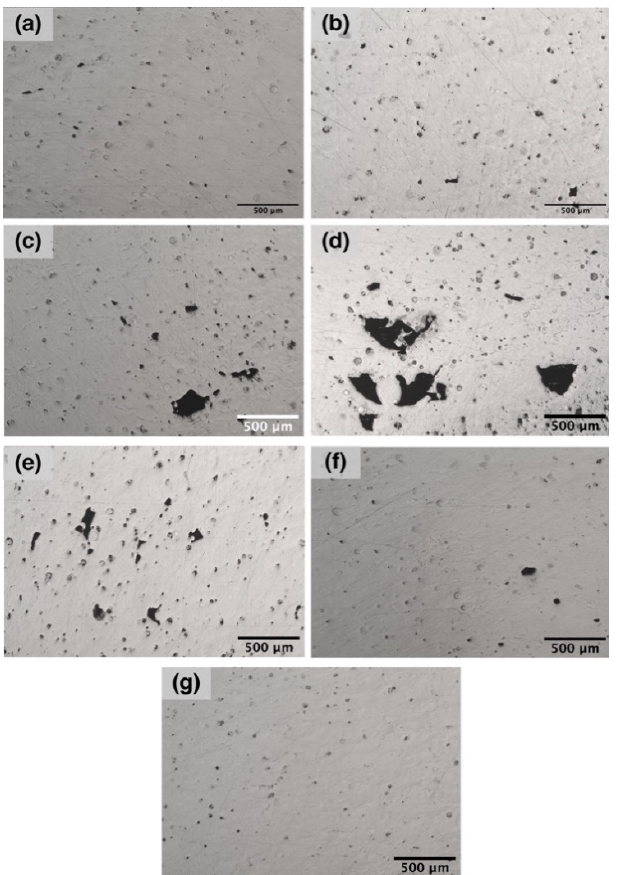
Figure 3. Optical images of the polished microsections for the samples produced using parameter